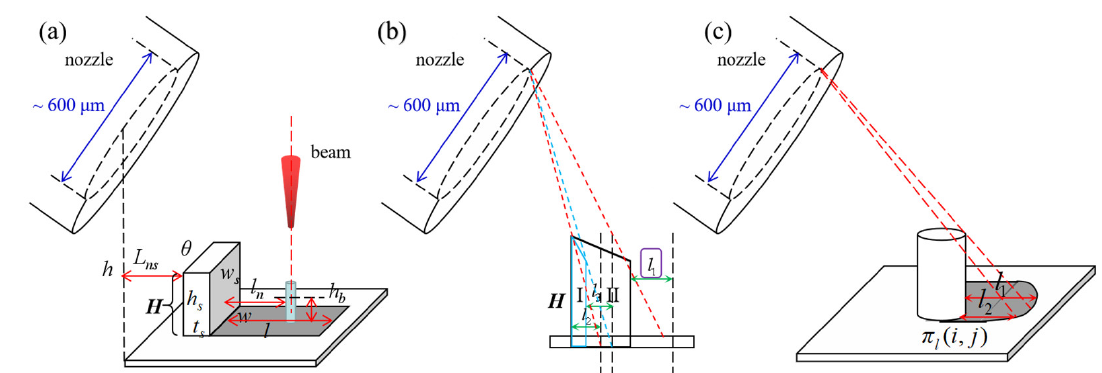
Figure 2. The schematic diagram of the shadow area defining model. ( a ) The definition of elements in the SADM; ( b ) the calculation of the shading length when there are different structure heights under the same i value; ( c ) the influence of the contour of the shading structure on the shading area.